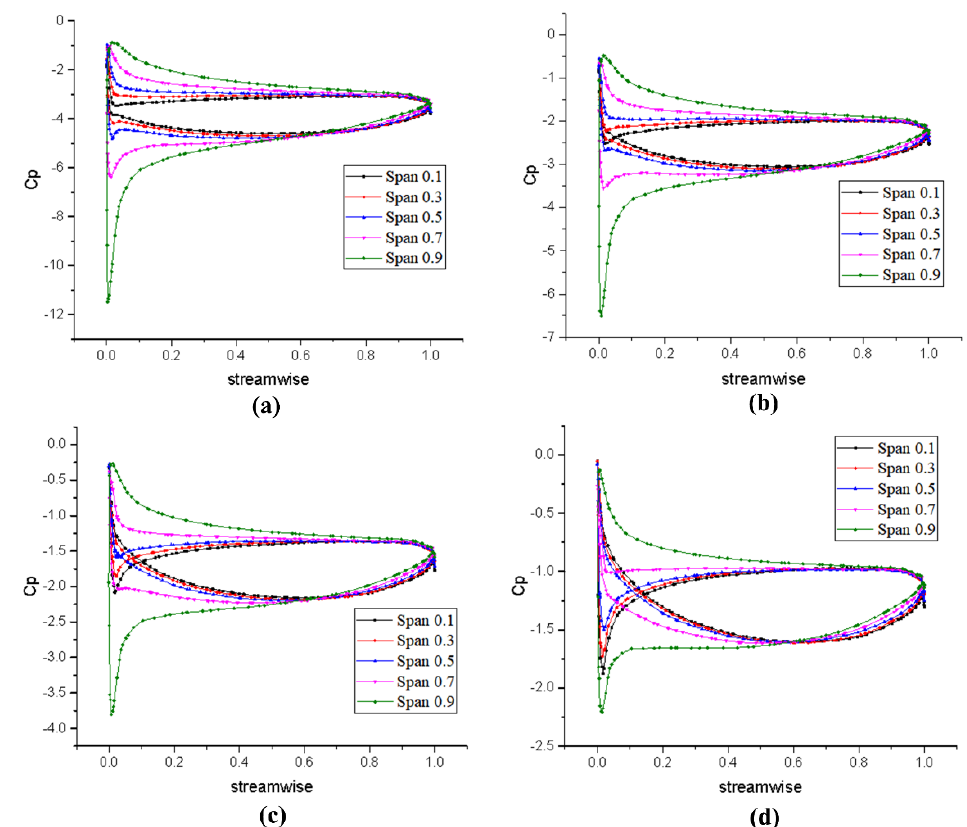
Figure 27. Tangential pressure distribution of stator after optimization: ( a ) v = 7 m/s ( J = 0.78), ( b ) v = 8.5 m/s ( J = 0.95), ( c ) v = 10 m/s ( J = 1.12), and ( d ) v = 11.5 m/s ( J = 1.28).